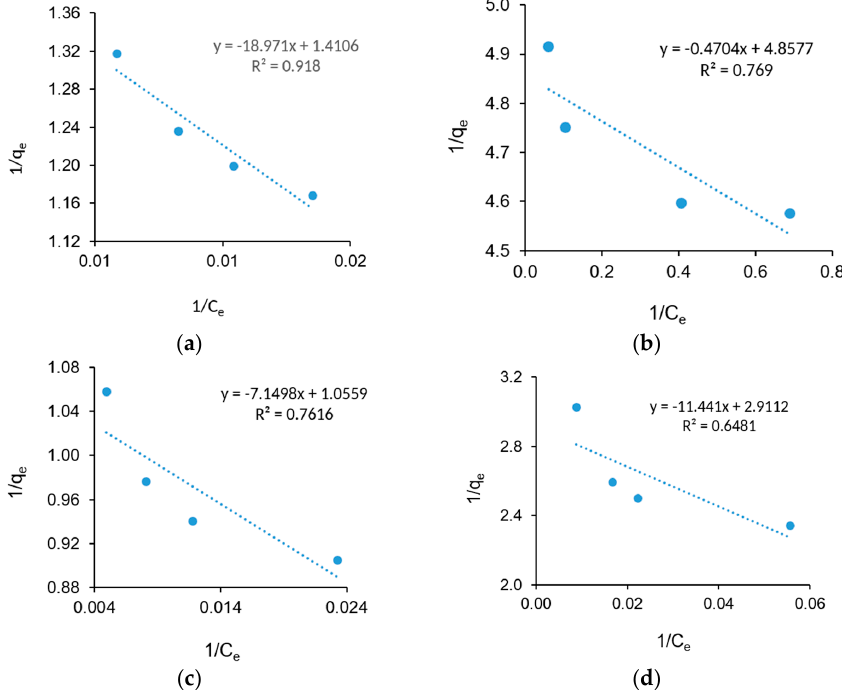
Figure 8. Langmuir adsorption isotherm modeling for the removal of ( a ) COD; ( b ) BOD; ( c ) SS; and ( d ) NH 3 from SRPE using FeSO 4 ·7H 2 O as a coagulant. Table 3. BET, Freundlich, and Langmuir model data for the removal of COD, BOD, SS, and NH 3 from Rubber processing effluent using FeSO 4 ·7H 2 O waste as a coagulant.